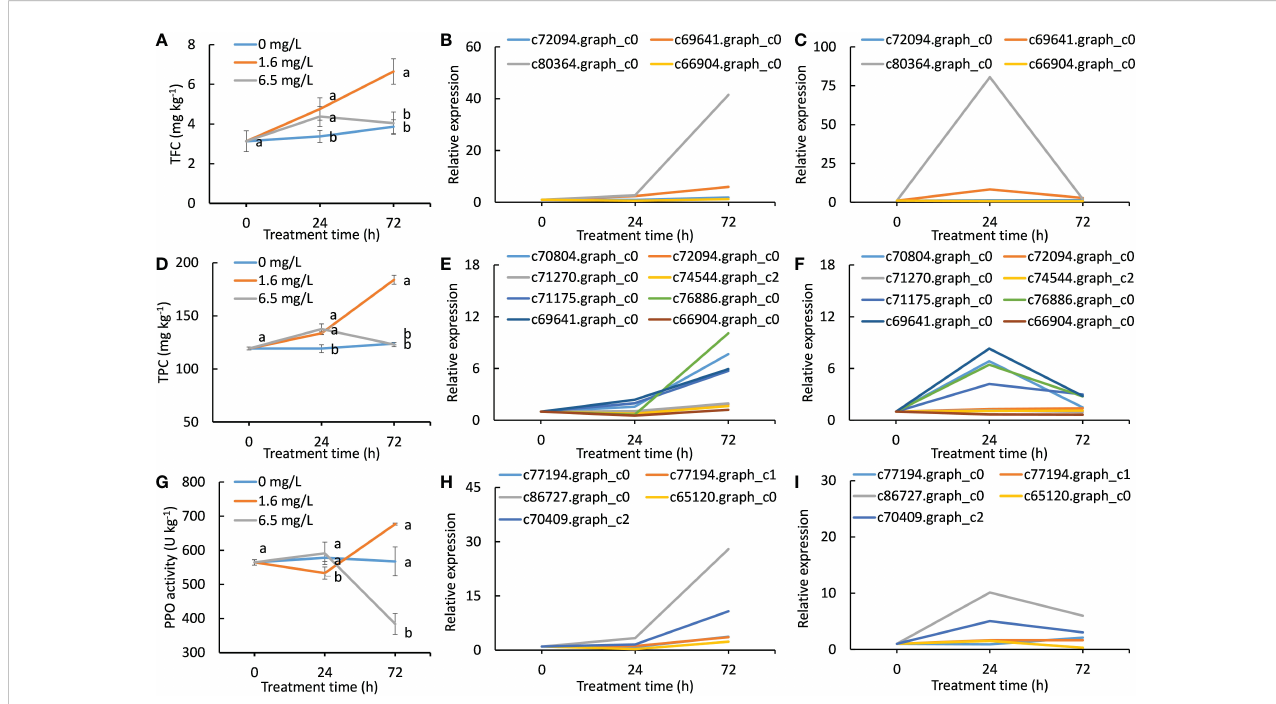
FIGURE 5 Effects of different degrees of Cd stress treatments on the biosynthesis of phenylpropanoids and fl avonoids and quinones. (A) , total fl avonoid contents of different Cd treatments in peppermint leaves; (B, C) , the expression patterns of DEGs involved in the biosynthesis of fl avonoids during low level of Cd treatment (1.6 mg L -1 ) and high level of Cd treatment (6.5 mg L -1 ), respectively; (D) , total phenolic contents in peppermint leaves; (E, F) , the expression patterns of DEGs involved in the biosynthesis of phenylpropanoid during low level of Cd treatment (1.6 mg L -1 ) and high level of Cd treatment (6.5 mg L -1 ), respectively; (G) , polyphenol oxidase (PPO) activity; (H, I) , the expression patterns of DEGs encoding PPO during low level of Cd treatment (1.6 mg L -1 ) and high level of Cd treatment (6.5 mg L -1 ), respectively. Each value is presented as means from three repeats. In fi gures (A, D, G) , statistical differences (p ≤ 0.05) between treatments are compared in the SPSS software and indicated using different letters above the